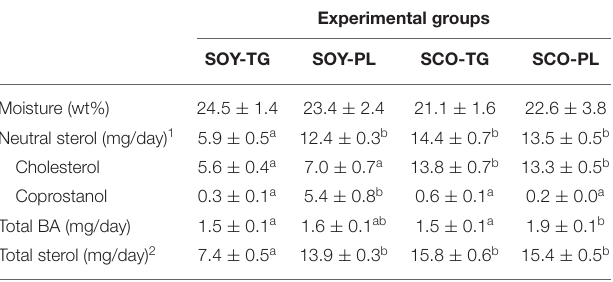
TABLE 6 | Moisture and sterol contents excretions of the